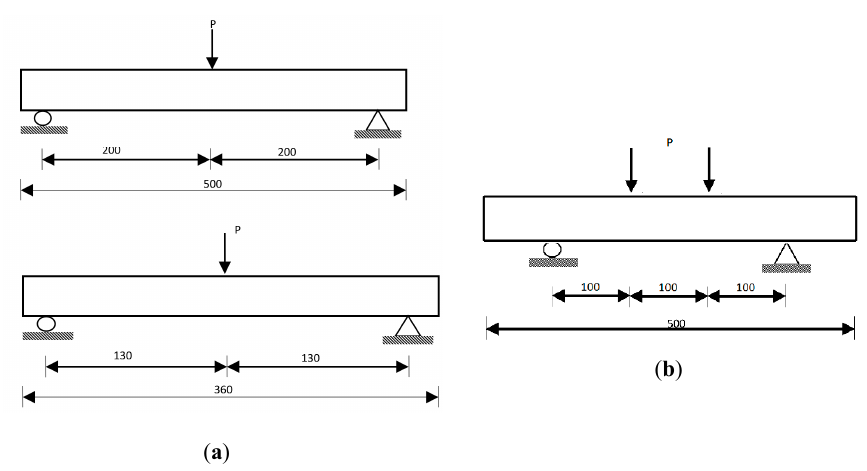
Figure 2. Schematic presentation of ( a ) the three-point bending test (UHPFRC-1) and ( b ) the four- point bending test (UHPFRC-2) (dimensions in mm).